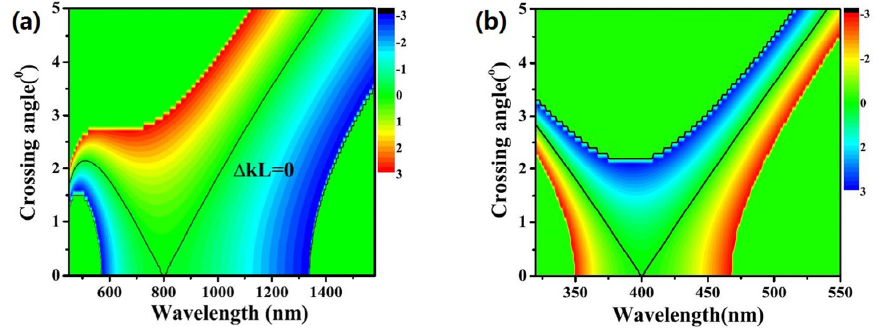
Figure 7. Two-dimensional phase-mismatch pattern plotted against the crossing angle and the probe wavelength when the pump wavelength was fixed at ( a ) 800 nm in a 0.1-mm-thick fused silica glass plate or ( b ) 400 nm in a 0.1-mm-thick CaF 2 plate. The black solid line corresponds to zero phase mismatch [43].